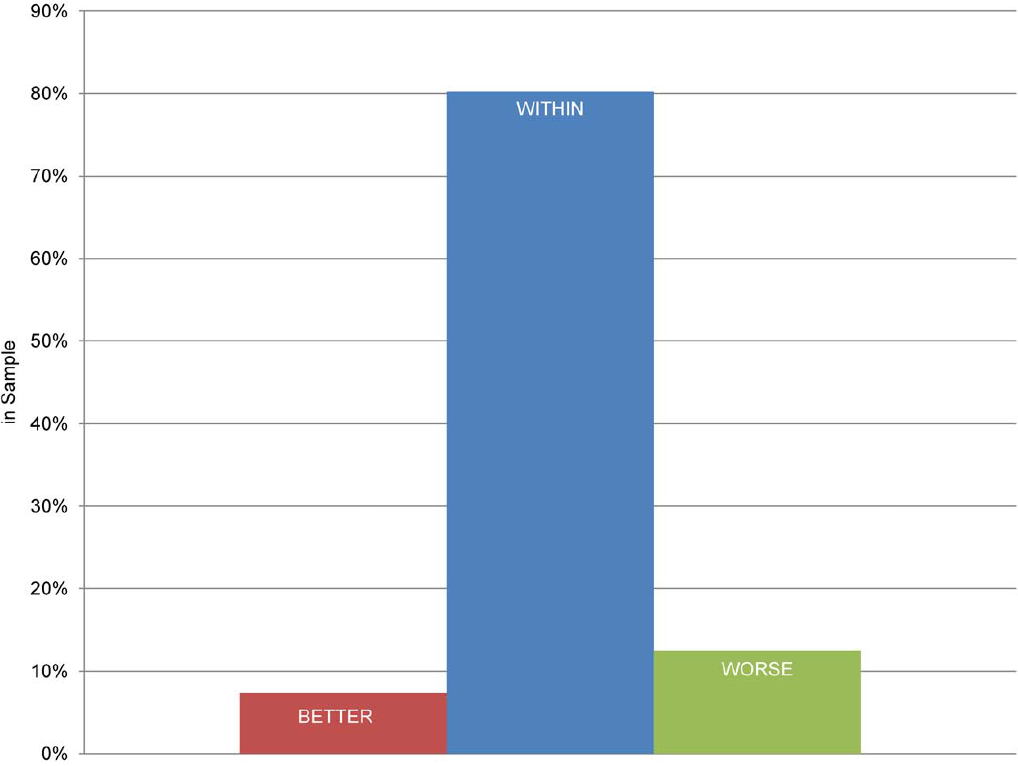
Figure 3. Range of Reviewer’s Preliminary versus SRGs Final Priority Scores. The average preliminary priority scores of reviewers may all be the same or represent a range. The final priority score was BETTER, WITHIN or WORSE than this range.